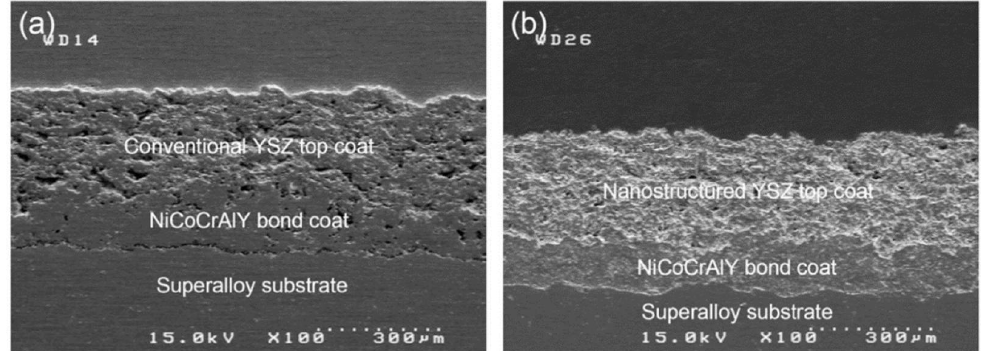
Figure 4. ( a ) FESEM polished cross-section micrographs of As-sprayed TBC with traditional or Conventional YSZ coating and ( b ) Nanostructure YSZ coating [13].